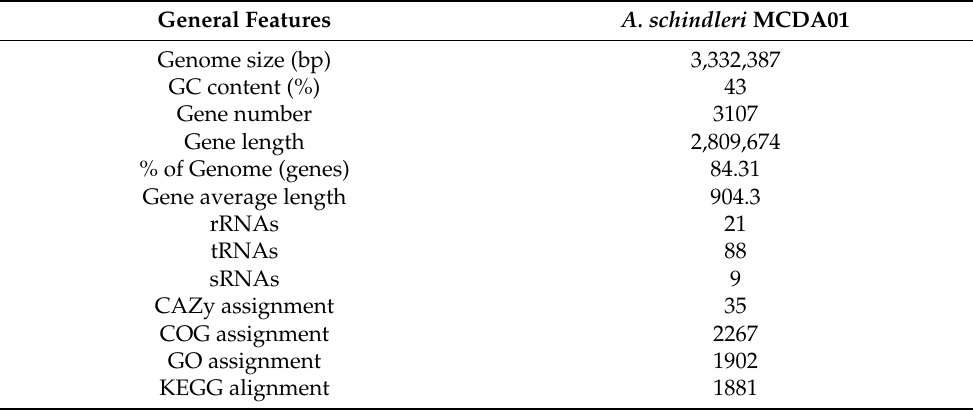
Table 1. General characteristics of the Acinetobacter schindleri MCDA01 genome. General